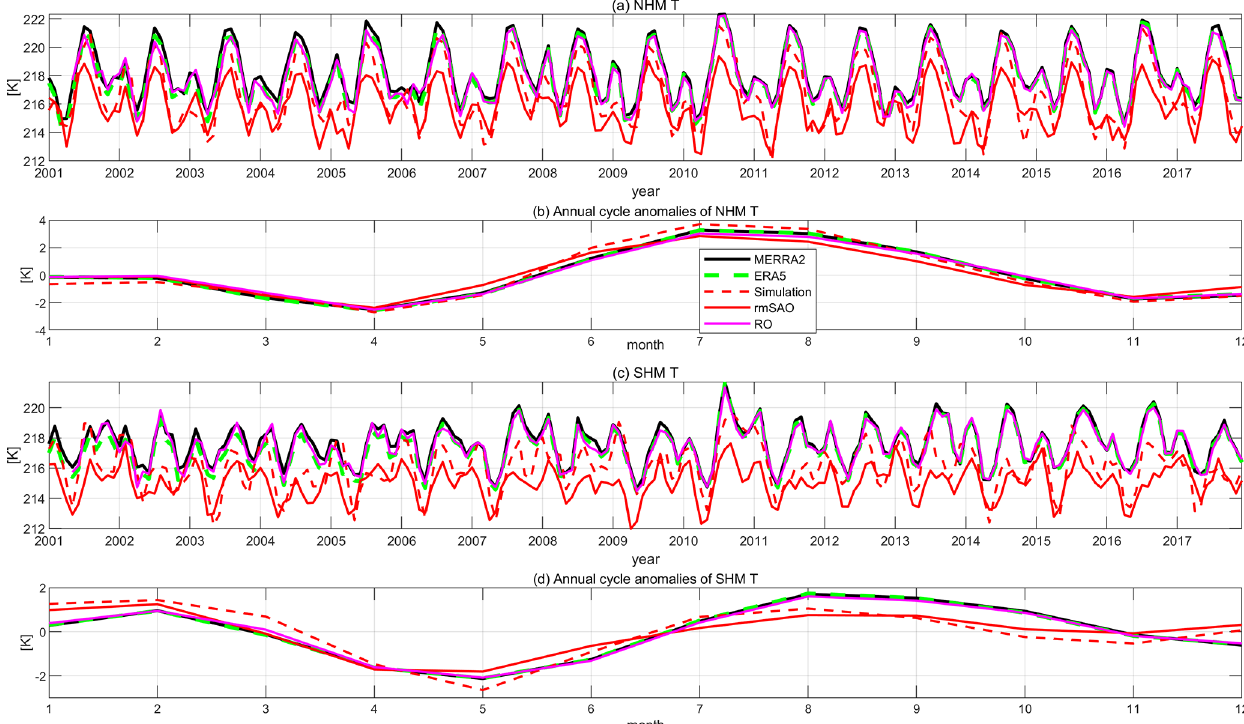
Figure 3. Time series of the zonal mean temperature ( T ) at 200hPa averaged around the Northern Hemisphere mid-latitudes (NHM) 32.5– 42.5 ◦ N (a) and their corresponding annual cycle anomalies (b) . The Southern Hemisphere mid-latitudes (SHM) 32.5–42.5 ◦ S (c) and their corresponding annual cycle anomalies (d)